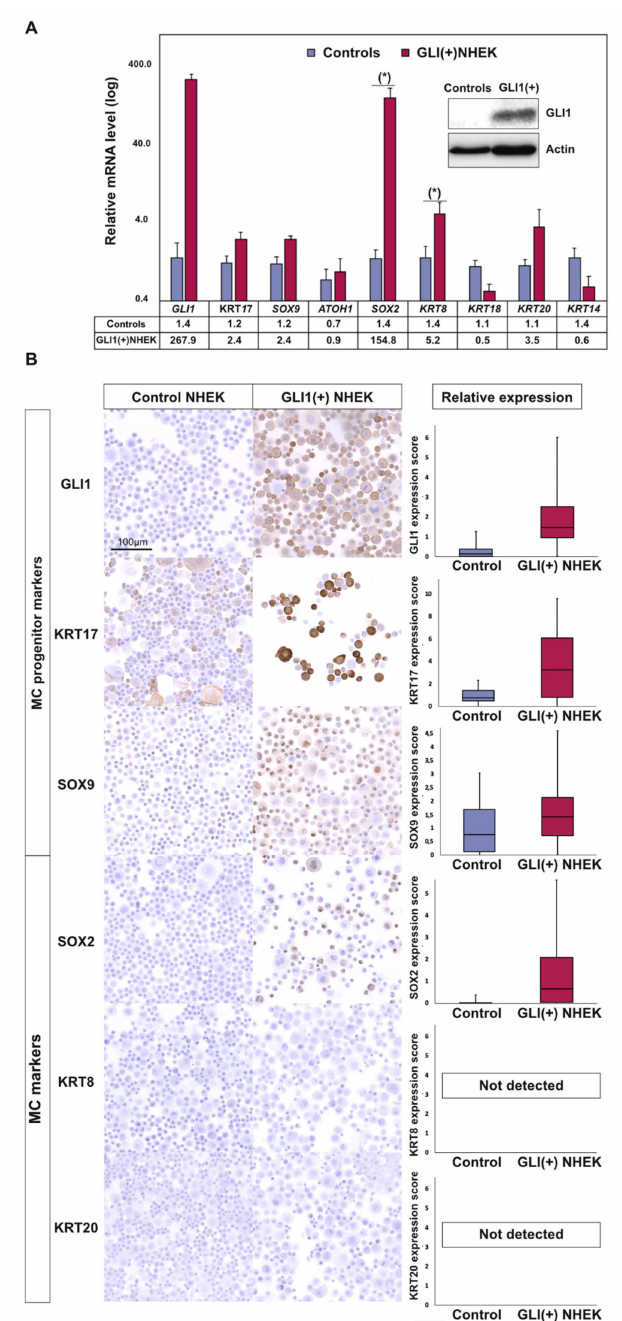
Figure 2. Ectopic GLI1 expression in primary human epidermal keratinocytes induces several MC lineage markers: Normal human epidermal keratinocytes (NHEK) were infected with a lentiviral vector coding for GLI1 and puromycin resistance. Following antibiotic selection, cells were harvested after 14 days of cultivation. ( A ) Immunoblot analysis was performed to confirm GLI1 expression (insert), and isolated RNA was subjected to complementary DNA (cDNA) synthesis and real-time PCR. Relative messenger RNA (mRNA) expression levels of the indicated Merkel cell lineage markers are given as mean ( + standard error of the mean (SEM)) of four independent experiments (* p value < 0.05, paired t test) (mean CT value of the controls was used as reference). ( B ) Expression of GLI1, the MC progenitor (KRT17, SOX9) and the MC markers (SOX2, KRT8, and KRT20) was assessed by immunohistochemistry and relative protein expression quantification was performed on at least 1000 cells / condition using ImageJ software. Results are displayed as box and whiskers diagram with median, Q1, and Q3, as well as first and 99th percentile. These results were confirmed by two additional independent experiments (immunostaining and immunoblot) as shown in Figure S3. Uncropped membranes and Western blot signal quantifications are available in Figures S8 and S9,